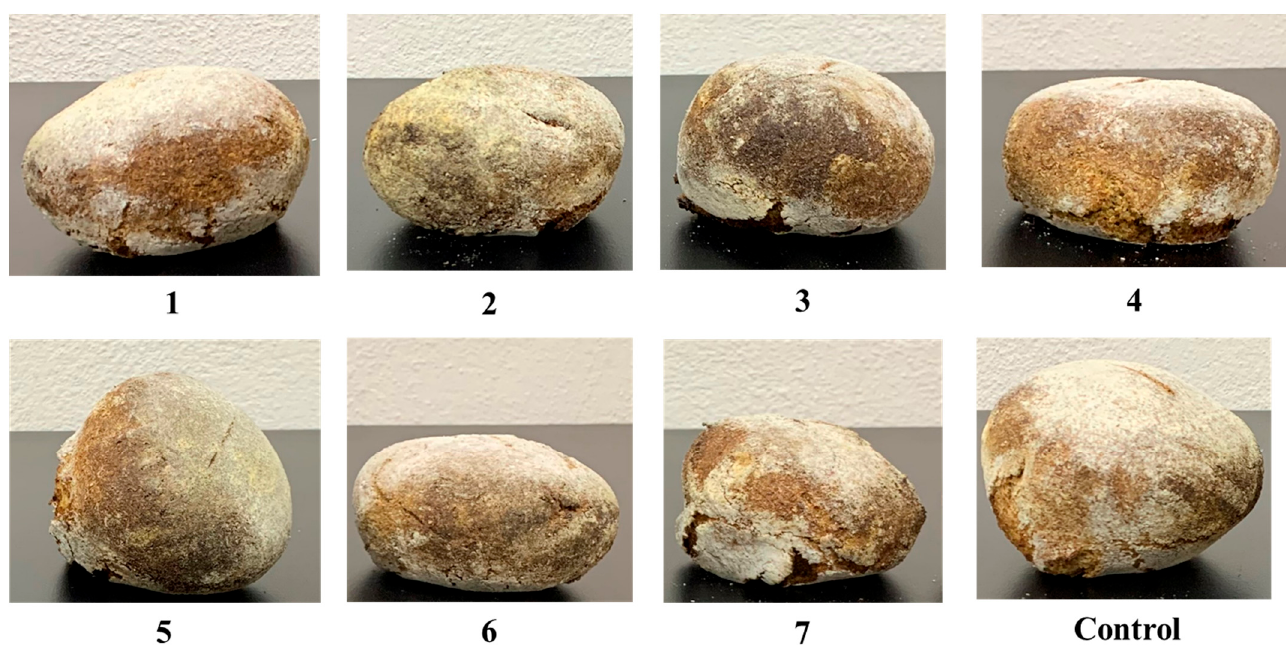
Figure 1. Visual appearance of bread treatments. Picture 1 (10 g PF-10 g GBF-80 g WF), 2 (10 g MF-10 g GBF-80 g WF), 3 (10 g PF-10 g MF-80 g WF), 4 (6.66 g PF-6.66 g GBF-6.66 g MF-80 g WF), 5 (20 g PF-80 g WF), 6 (20 g GBF-80 g WF), 7 (20 g MF-80 g WF), control (100 g WF-aguamiel), PF (pea flour), GBF (green bean flour), MF (mesquite flour), WF (whole-wheat flour).